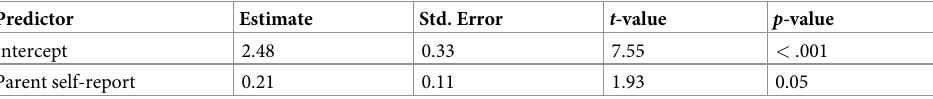
Table 11. Results from linear regression predicting adolescents’ mean predictions about their parents as a func- tion of their parents’ scores.